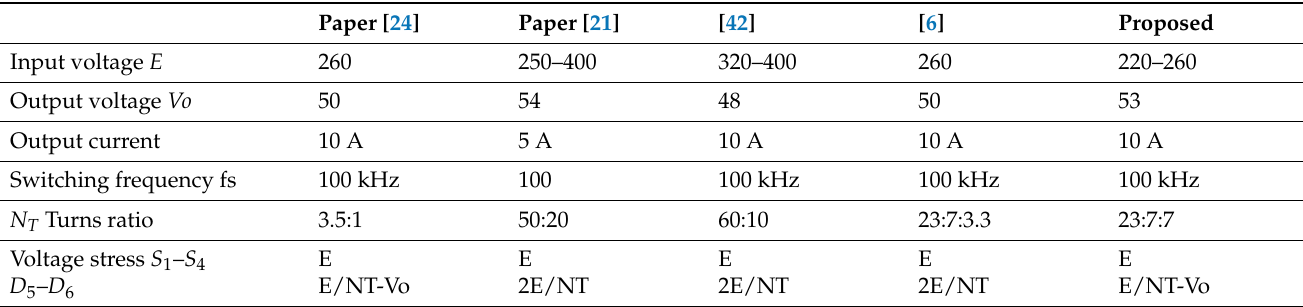
Figure 13. Efficiency comparison between the conventional and developed converter. Table 3. Comparison between the proposed and Table 2. Comparison of voltage and current stresses of the proposed and conventional converter.